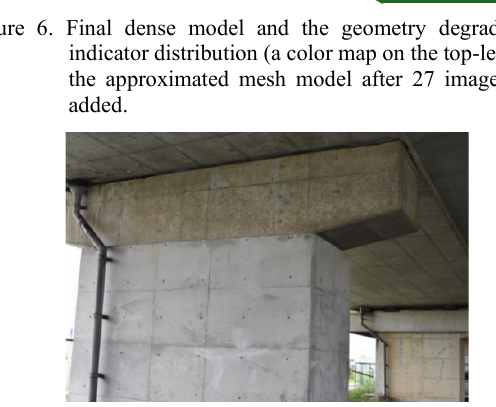
Figure 7. The bridge column used for the